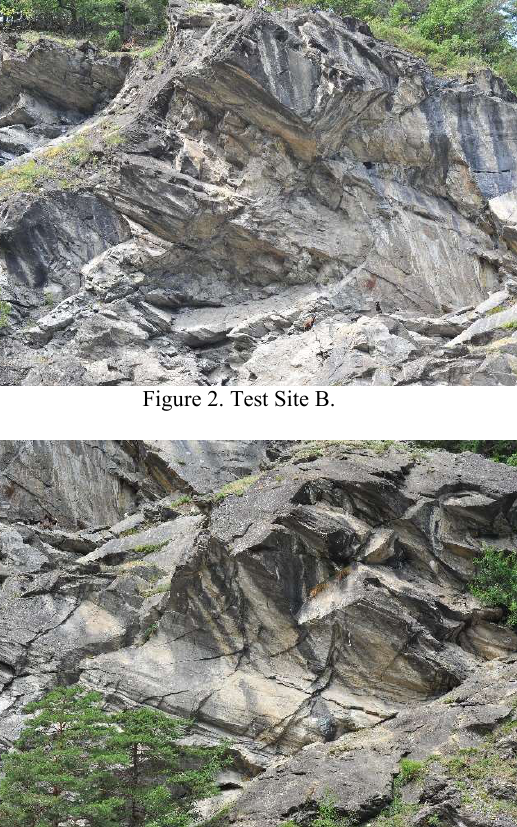
Figure 3. Test Site C.